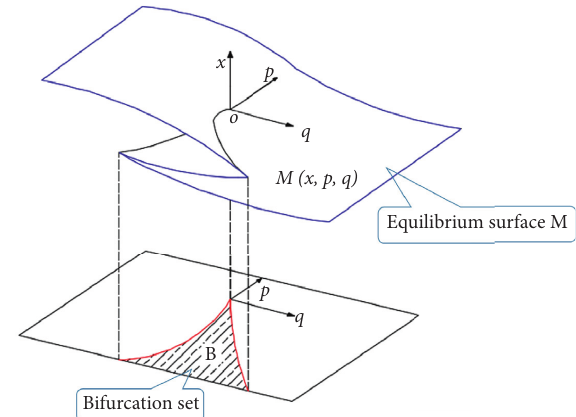
Figure 4: Equilibrium surface and the bifurcation set of cusp catastrophe